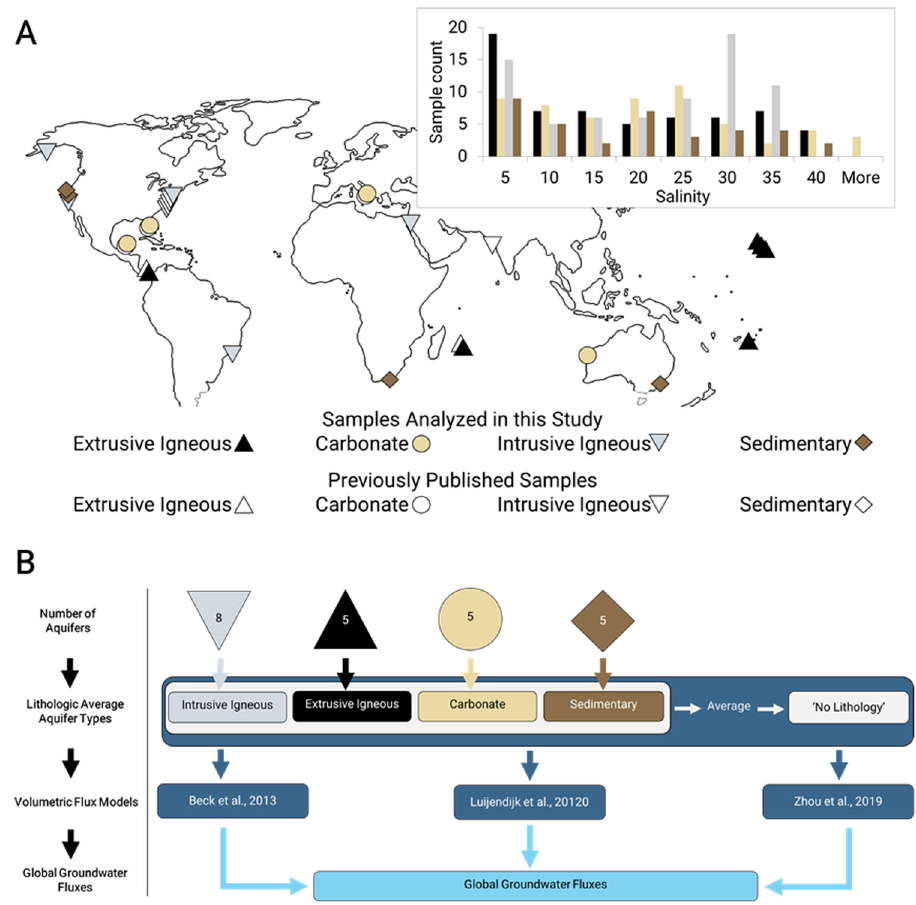
Fig. 1 Overview of study design. a Map of aquifer locations ( n = 27) from which data were utilized and an inset bar chart showing the number of samples from each salinity range used in this study ( n = 229; this study and previously published data). b Flow diagram summarizing the calculation pathway to global groundwater-derived solute fl